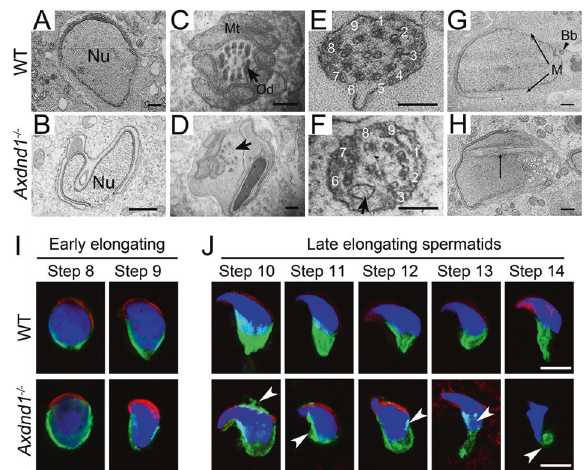
Fig. 6 Axdnd1 deletion in mice leads to abnormal spermatid development in late spermiogenesis. A – H Transmission electronic microscopy (TEM) analysis of testicular spermatids in WT and Axdnd1 − / − mice. A normal condensing sperm nucleus in WT elongating spermatids (step 8 – 9) is shown in ( A ) and an irregular- shaped sperm nucleus coupled malformed acrosome in Axdnd1 − / − elongating spermatids is shown in ( B ). The cross-section of fl agella in WT (C and E) and Axdnd1 − / − ( D and F ) elongated spermatids